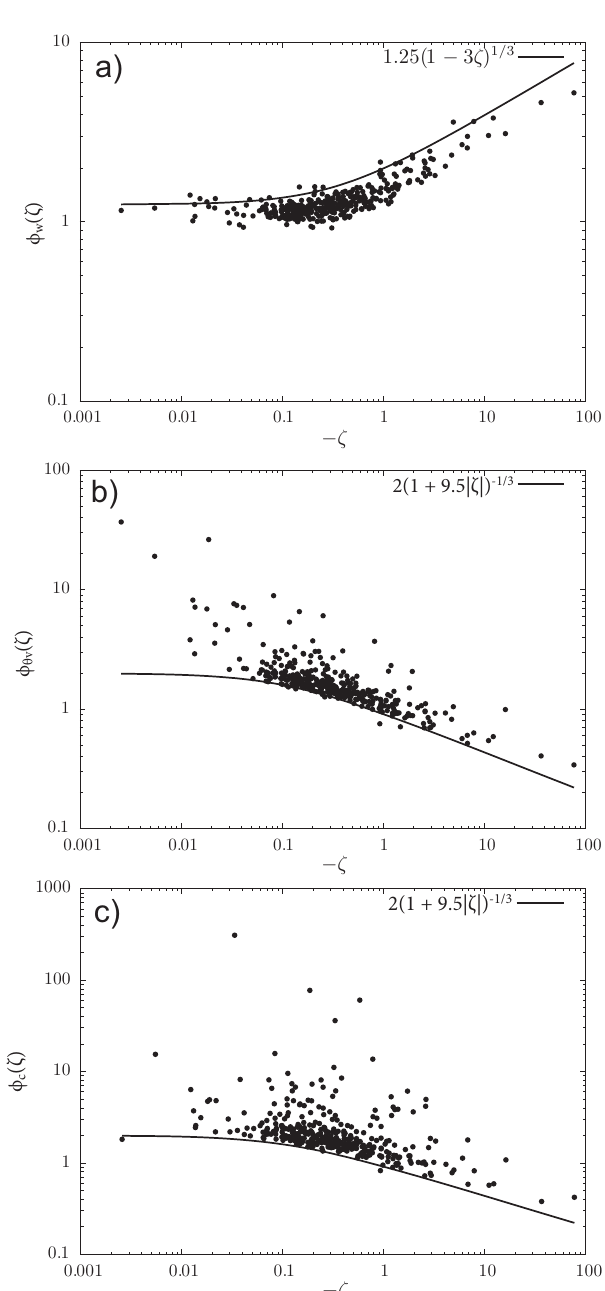
Figure 10. The dimensionless standard deviation function for (a) vertical velocity (cid:56) w (ζ) , (b) virtual temperature φ θ (c) CO 2 concentration φ c (ζ) for the ATTO site from measurements at